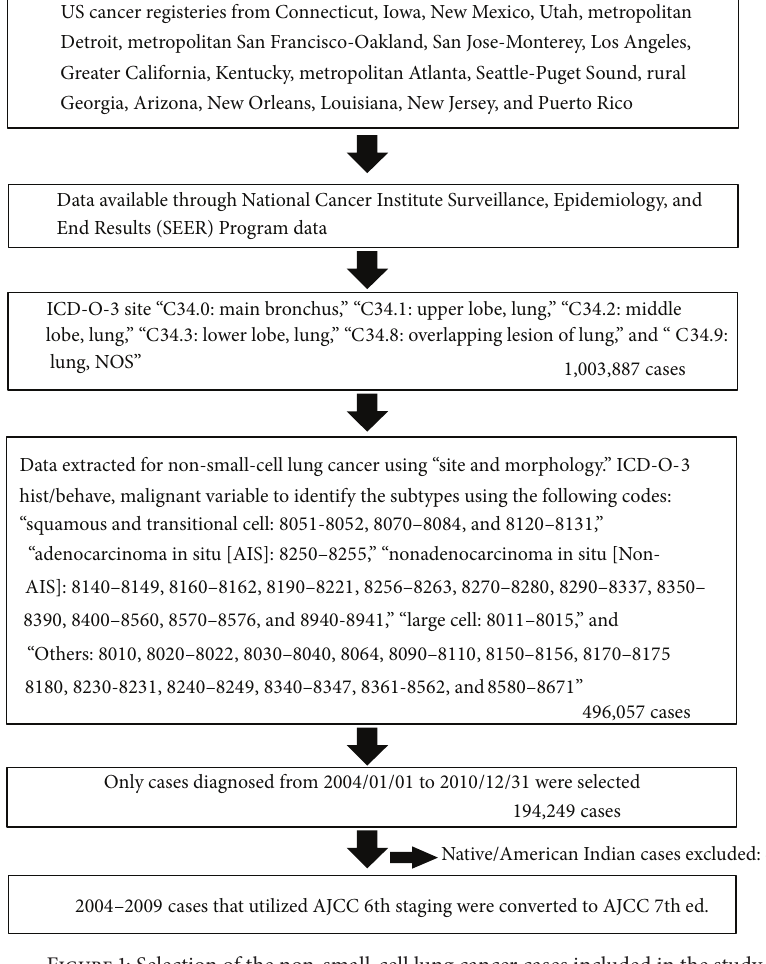
Figure 1: Selection of the non-small-cell lung cancer cases included in the